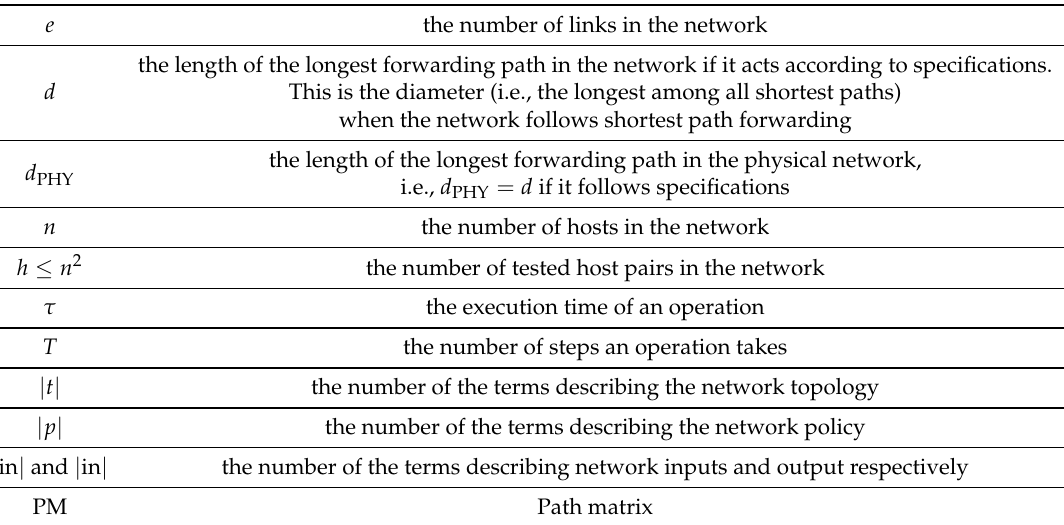
Table 3. Summary of notations for performance